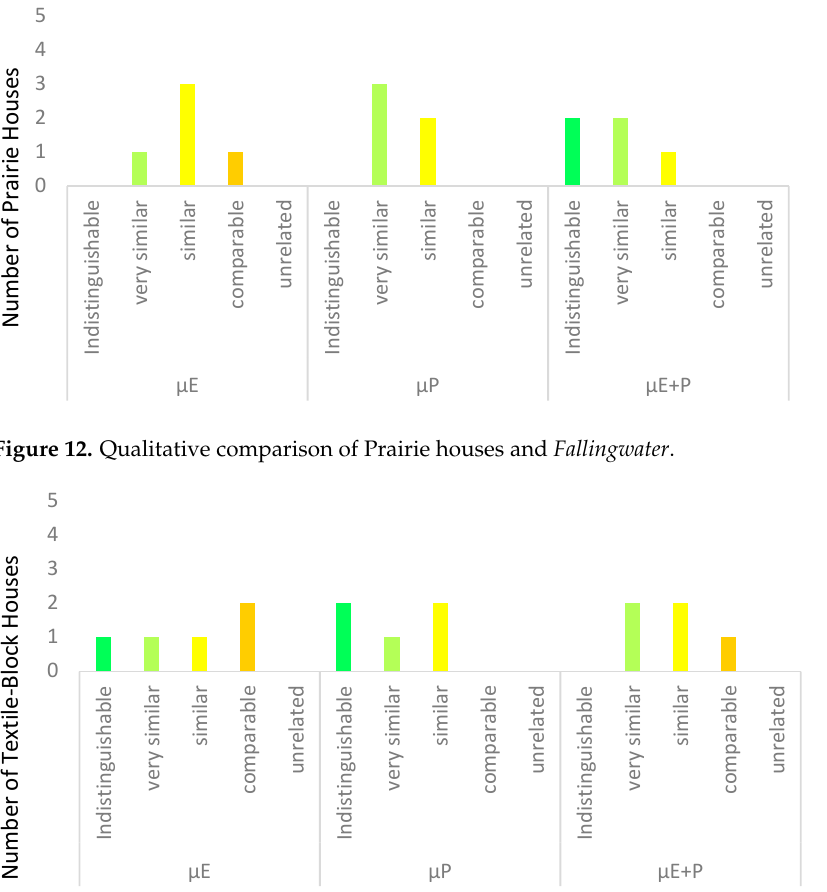
15 of 21 Table 7. Comparison of mean results for all houses. Period